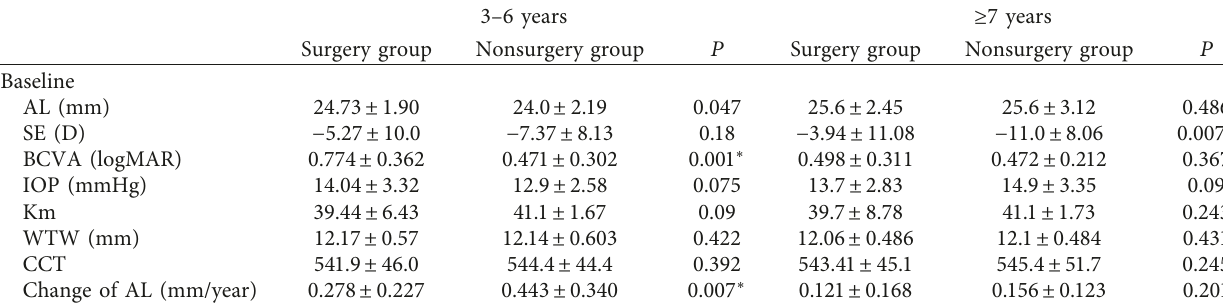
Table 2: Baseline and the changing trend of ocular parameters in the surgery group and the nonsurgery group of CEL